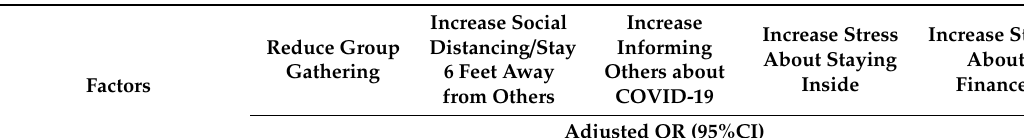
Increase Increase Social Increase Stress Increase Stress Informing Distancing / Stay Reduce Group About About Staying Others about 6 Feet Away Gathering Finances Inside COVID-19 from Others Adjusted OR